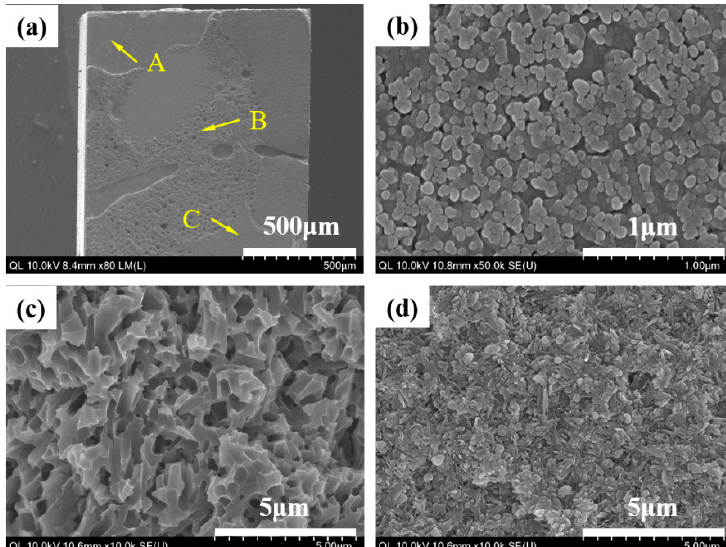
Figure 6. HR FE-SEM images of the liner-bonded group demonstrating mode of failure with the microtensile bond strength test. ( a ) Fracture surface of specimen demonstrating inhomogeneous pattern of fracture, ( b ) magnification of point A demonstrating that the zirconia surface layer reacted with the liner, ( c ) the magnification of point B demonstrating the microstructure of the liner, and ( d ) the magnification of point C demonstrating the presence of needle-shaped lithium disilicate crystals in the lithium disilicate-reinforced glass ceramic.